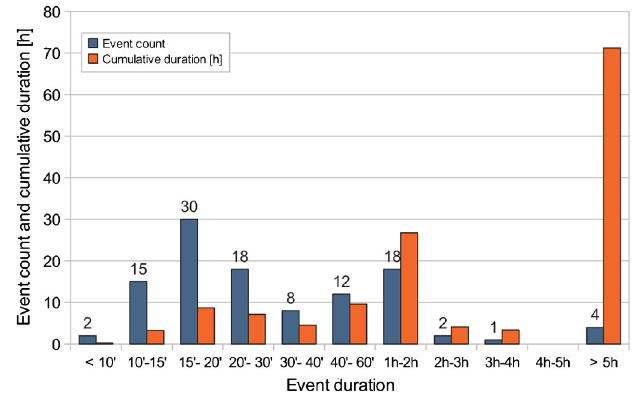
FIG. 8. (Color) Durations of downtimes in 2007, calculated from the data from the operation event database.